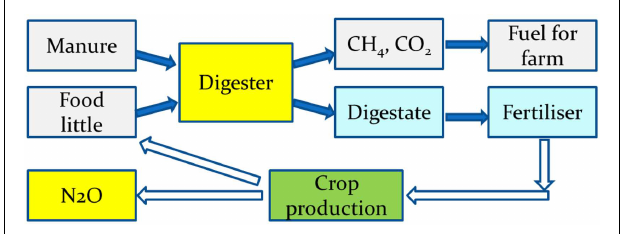
FIGURE 1 | Schematic of farm ecosystem withAD biogas production